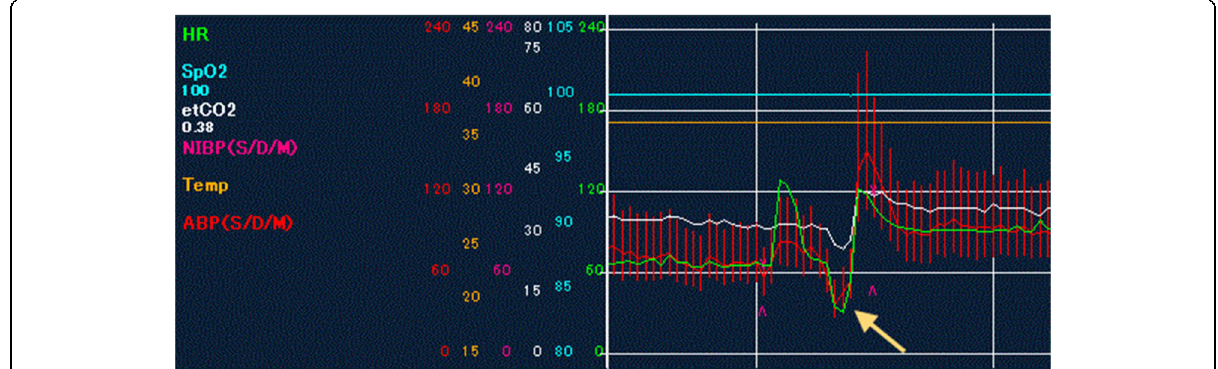
Fig. 2 The monitor record shows the heart rate (green line and yellow arrow) dropped to 30s. It returned normal soon after a cardiac massage was performed and a coronary vasodilator was